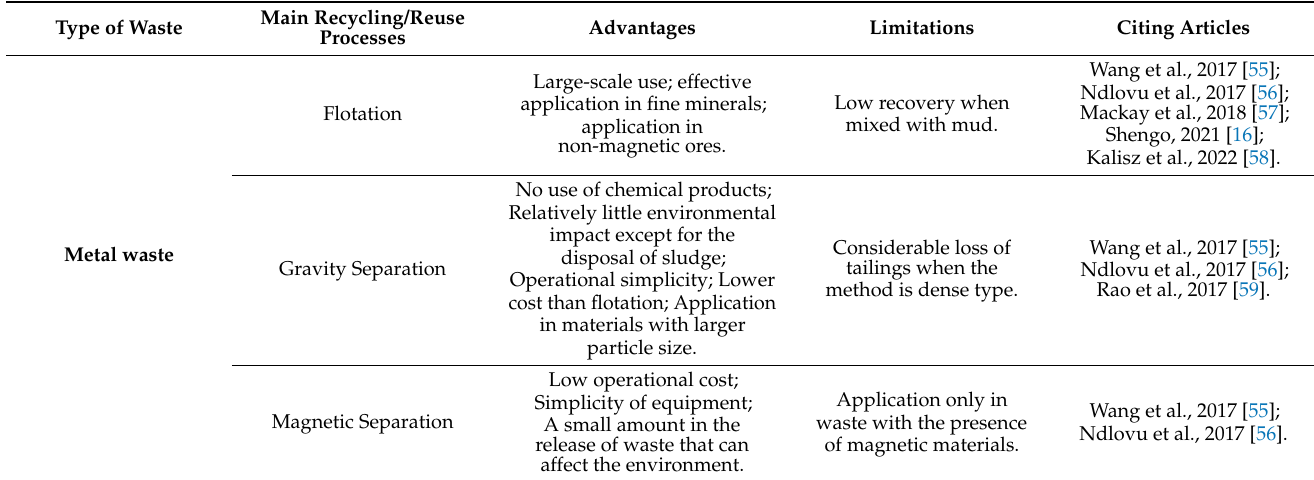
Table 3. The relationship between types of mine waste and their main recovery